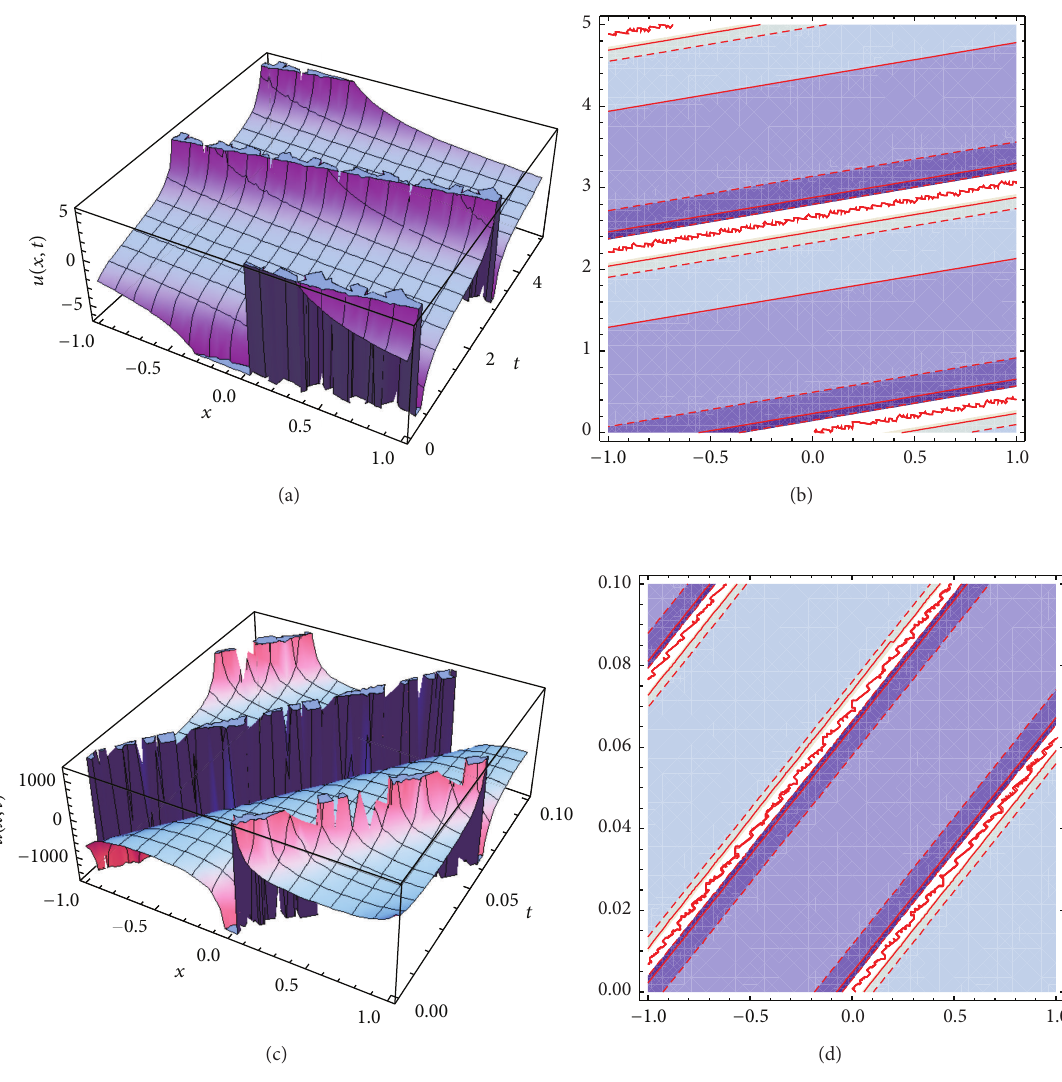
Figure 2: Travelling waves solutions (20) with various different shapes are plotted: periodic solitary waves in (a) and contour plot in (b). Travelling waves solutions (22) with various different shapes are plotted: periodic solitary waves in (c) and contour plot in